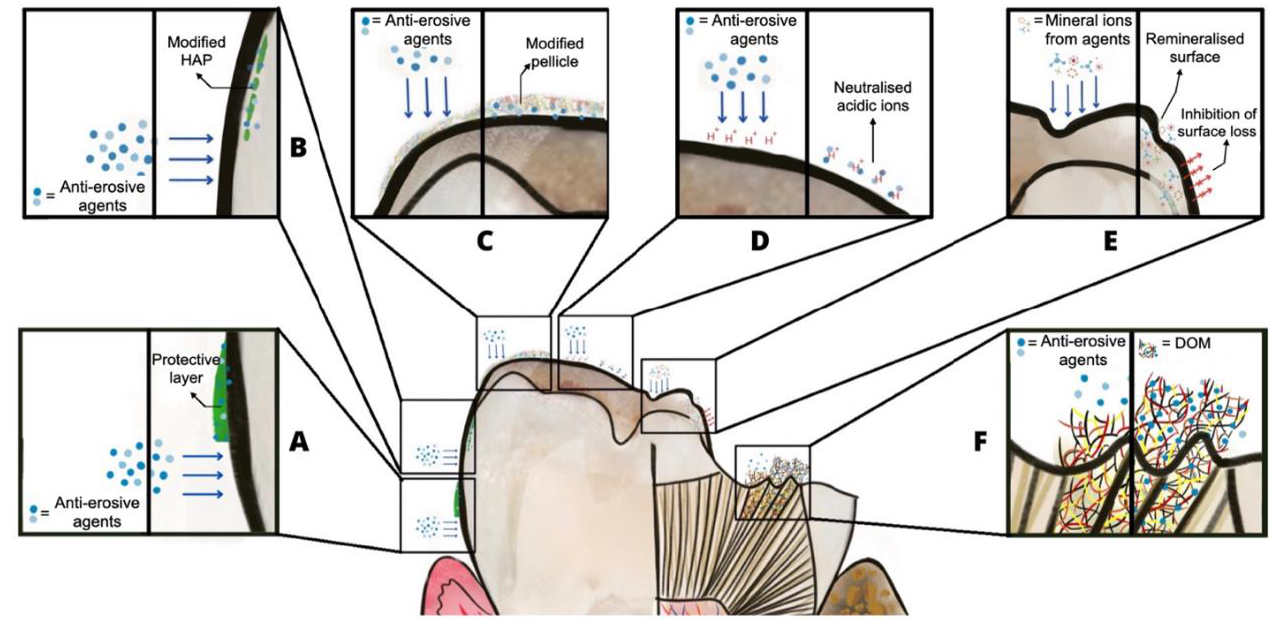
Figure 3. Anti-erosive properties of the topical anti-erosive agents: ( A ) form a protective layer on the tooth surface, ( B ) modify hydroxyapatite, ( C ) modify salivary pellicle, ( D ) neutralise acidic ions, ( E ) supply mineral ions and ( F ) inhibit MMP activation.